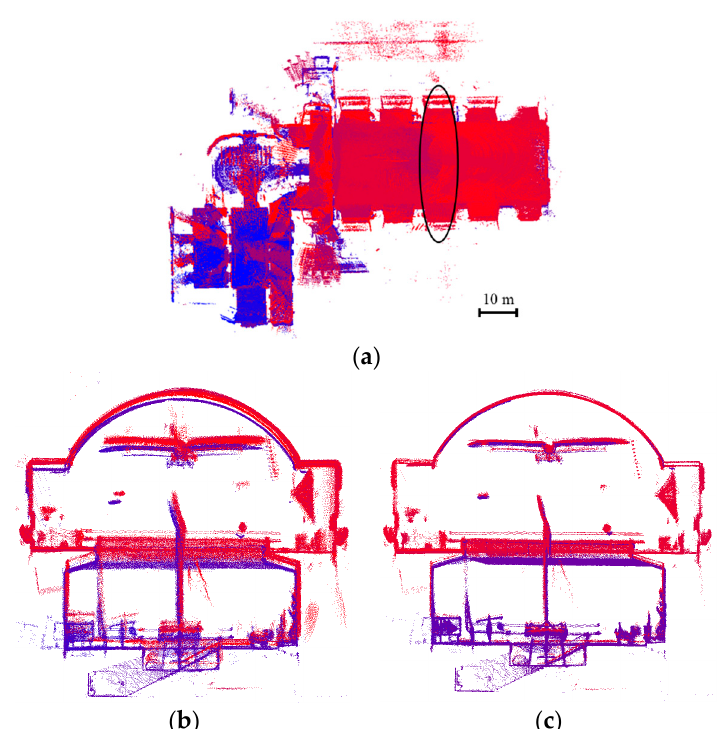
Figure 20. Comparison between the point clouds before and after optimization in the Cartographer dataset. ( a ) The top view of the point cloud after optimization; ( b ) section view of the raw output point cloud; ( c ) section view of the optimized point cloud. The color render mode is same as Figure 13.